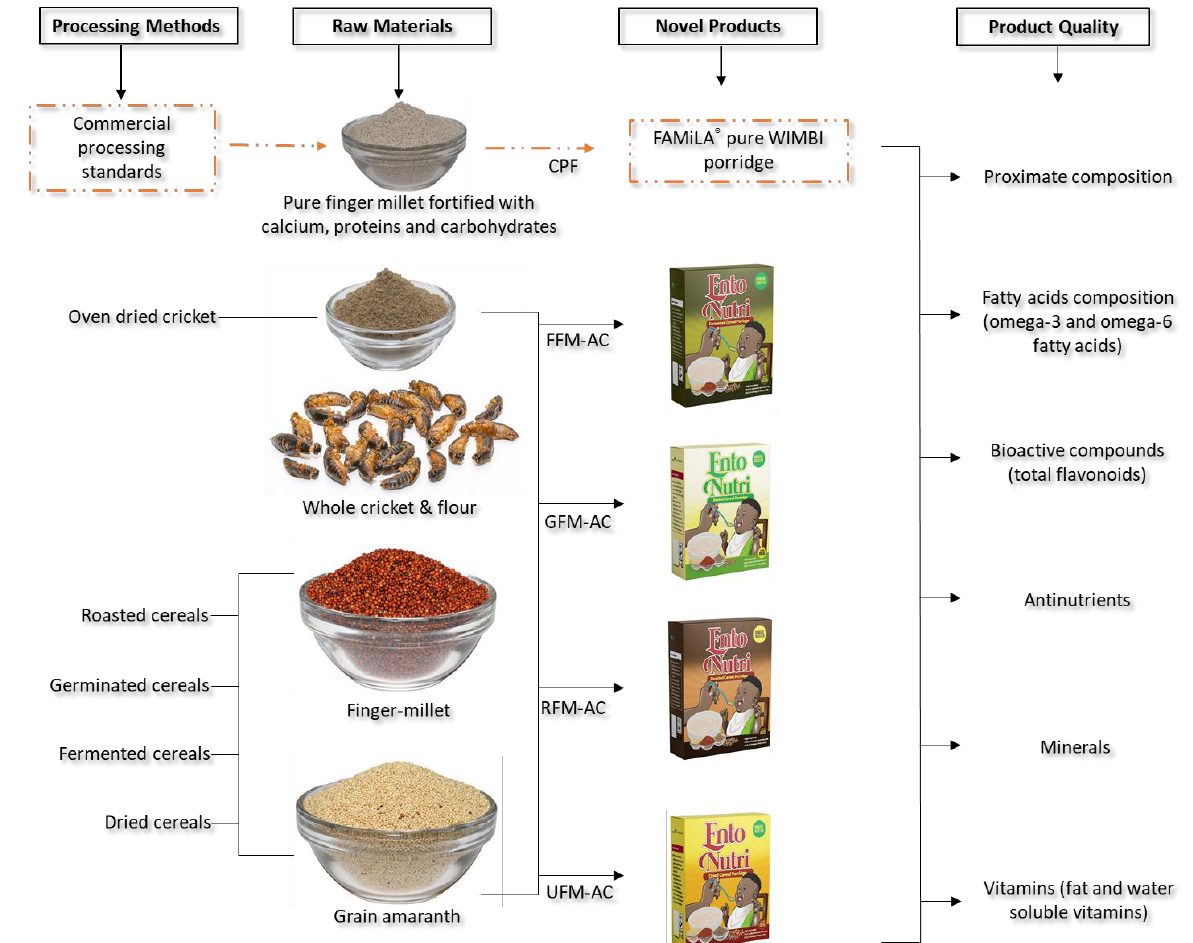
Figure 1. Flow diagram showing the raw materials (grain amaranth, finger-millet, and cricket) and the formulated porridge products [CPF = commercial porridge flour; FFM–AC = fermented finger millet − amaranth + cricket; GFM–AC = germinated finger millet − amaranth + cricket; RFM–AC = roasted finger millet − amaranth + cricket; and UFM–AC = unprocessed finger millet − amaranth +